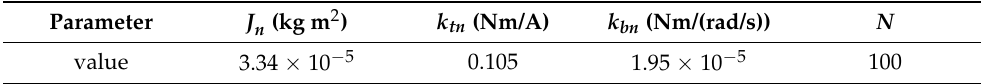
Table 1. The nominal parameters of the electric oil-filled joint actuator.